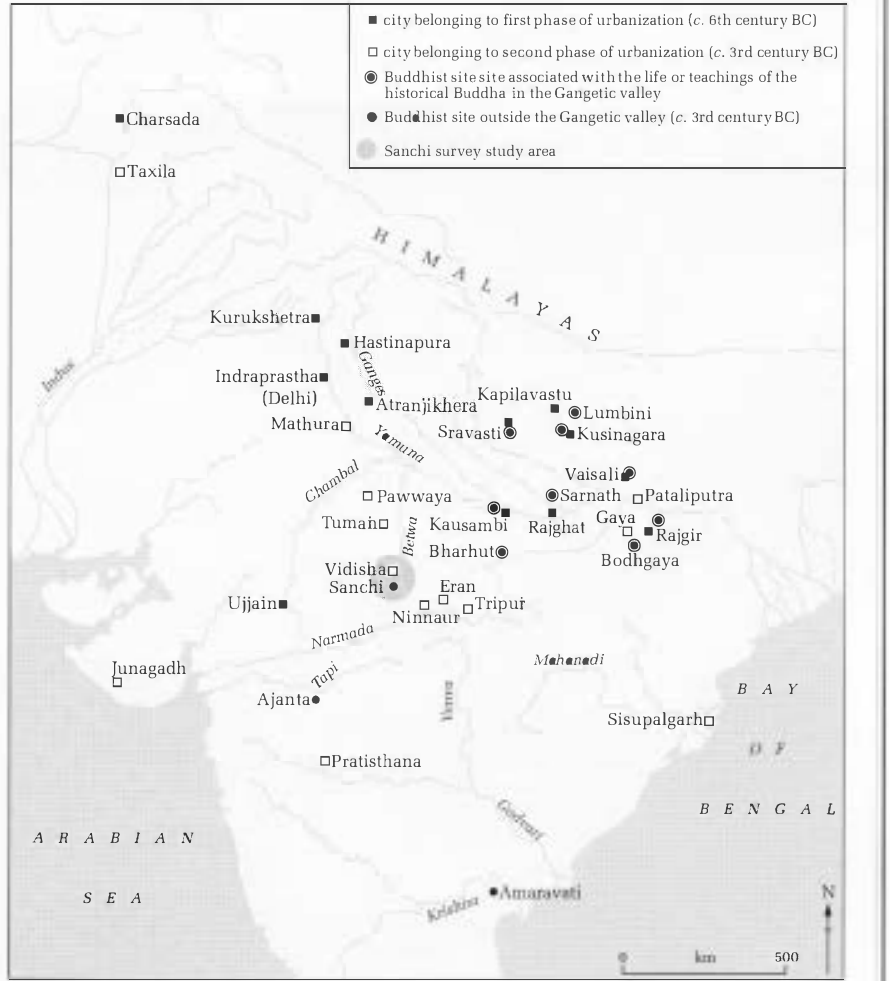
Figure 1 Ancient India, showing key Buddhist and urban centres, and Sanchi survey study area in